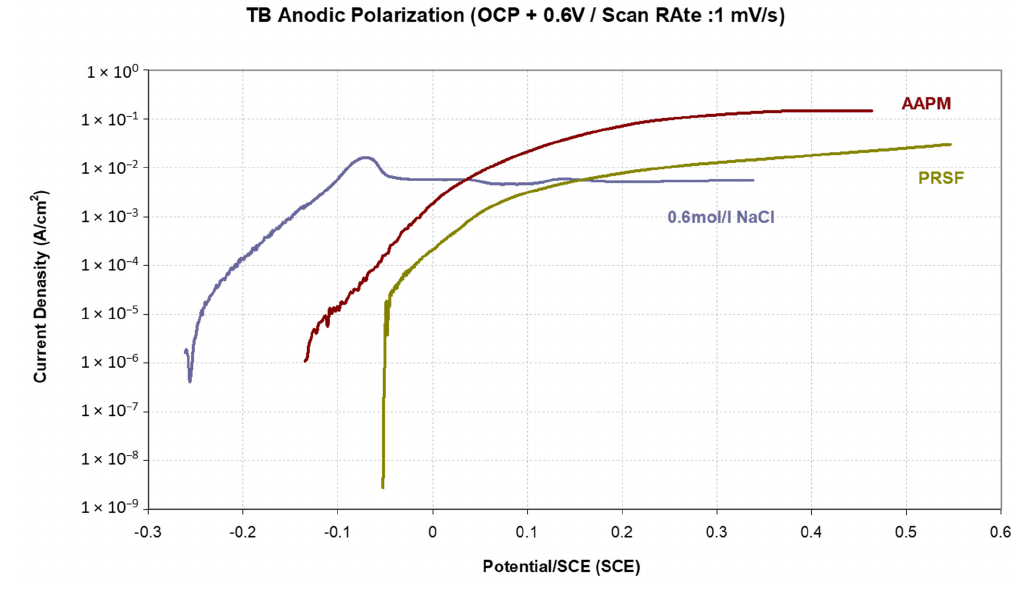
Figure 3. Anodic polarization curves (OCP+ 0.6 V) acquired in the three corrosive media at a typical scan rate of 1 mV/s, after 1 h at OCP conditions. Data first presented in [28]. OM images of electrochemical patina grown on a TB ‐ 0.6 mol/L NaCl system are pre ‐ sented in Figures 4 and 5. The local patterns from electrode edge (Figure 4) and centre (Figure 5) reveal a variety of precipitated dissolution products which follow the cored dendritic structure of the alloy substrate. ( a ) ( b ) Figure 4. OM images (×100) of the corrosion patterns observed at the segregated surface of TB castings after the end of anodic sweeps in 0.6 mol/L NaCl: ( a ) corroded dendritic structure and ( b ) Cu(II) corrosion products formation inside voids —These features are encountered near the elec ‐ trode edge. The centres of dendrites bodies and branches correspond to the metallic Cu or oxi ‐ dized Cu(I) state, while dendrite boundaries (shown in pink colour) are a mixture of Cu(I) and Sn(IV) compounds. The interdendritic areas are covered by white Sn(IV) compounds, which contribute to the stabilization behaviour of the alloy at high anodic potentials. In Figure 4b, the evolution of green Cu(II) hydroxyl ‐ chlorides inside the voids is observed.